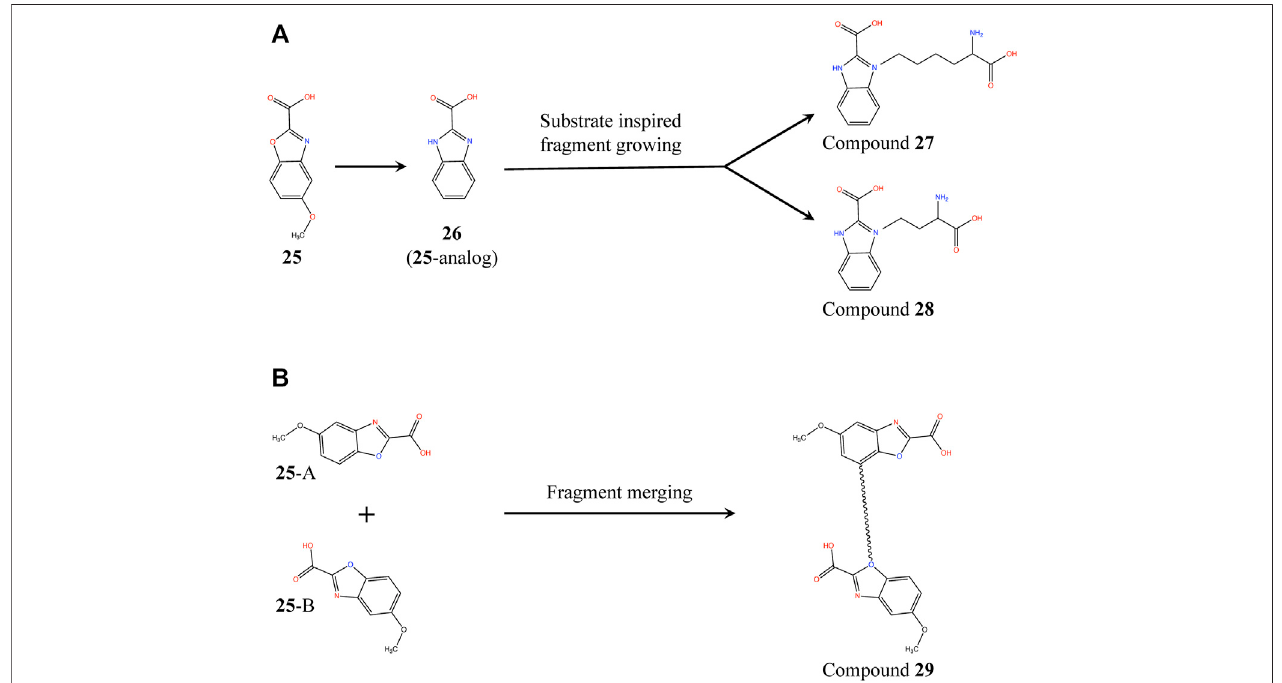
FIGURE 10 | Fragment growing and fragment merging strategies based on the structure of Pa DapD- 25 and Pa DapD-L2AP complexes. (A) substrate-inspired growing of an 25 -analog ( 26 ) based on the structures of Pa DapD- 26 and Pa DapD-L2AP complexes resulting in compound 27 and 28 . The feasibility of the fragment growing is enhanced when performed on 26 , (B) Merging of 25 at sites A and B of Pa DapD employing suitable linker based on the structure of Pa DapD- 25 complex to develop compound 29 . The binding and inhibition of these compounds to Pa DapD needs to be investigated.